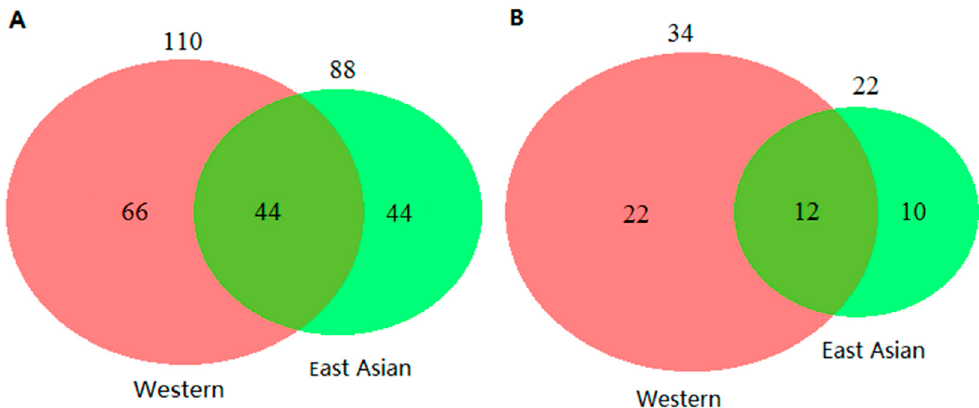
Figure 3. Venn diagrams showing numbers of miRNAs with reported significant associations with lung cancer for Western and East Asian studies. ( A ) miRNAs reported in ≥ 1 study and ( B ) miRNAs reported in ≥ 2